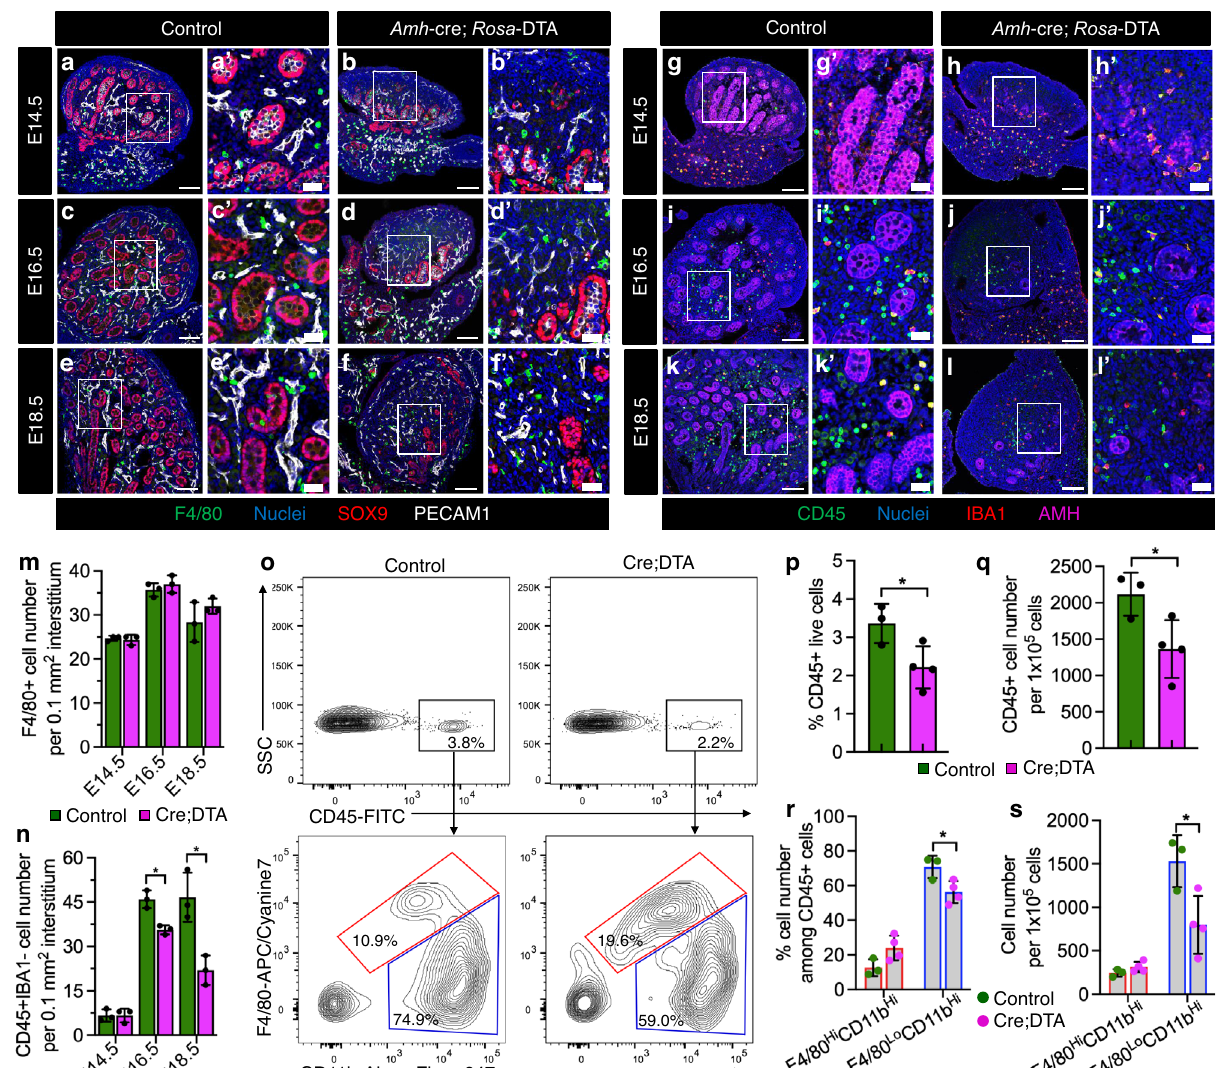
Fig. 5 | Sertoli cells regulate testicular immune cell recruitment. a – l Representativeimages( n =3independentgonads)ofcontrol( a , c , e , g , i , k )and Amh- cre; Rosa -DTA ( b , d , f , h , j , l ) testes at various fetal stages. Thin scale bar, 100 μ m; thick scale bar, 25 μ m. m , n Graphs showing number ( n =3 independent gonads)ofF4/80 + cells(m)ornumberofCD45 + IBA1-negativecells( n )perunitarea ofgonadalinterstitiumatE14.5,E16.5,orE18.5incontrolversus Amh- cre; Rosa -DTA fetal testes, as determined by stereology-based cell counts. o Representative fl ow cytometryanalysesofE18.5control(left)and Amh- cre; Rosa -DTA(right)fetaltestes for CD45 + cells (top) and for F4/80-hi CD11b-hi (macrophages;red gate) versus F4/